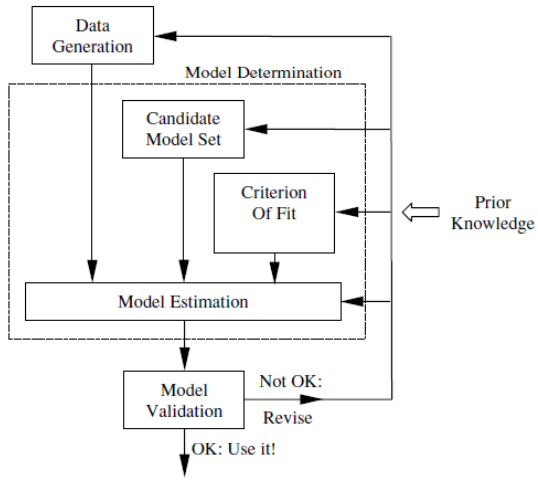
Figure 2. The system identification loop [26].